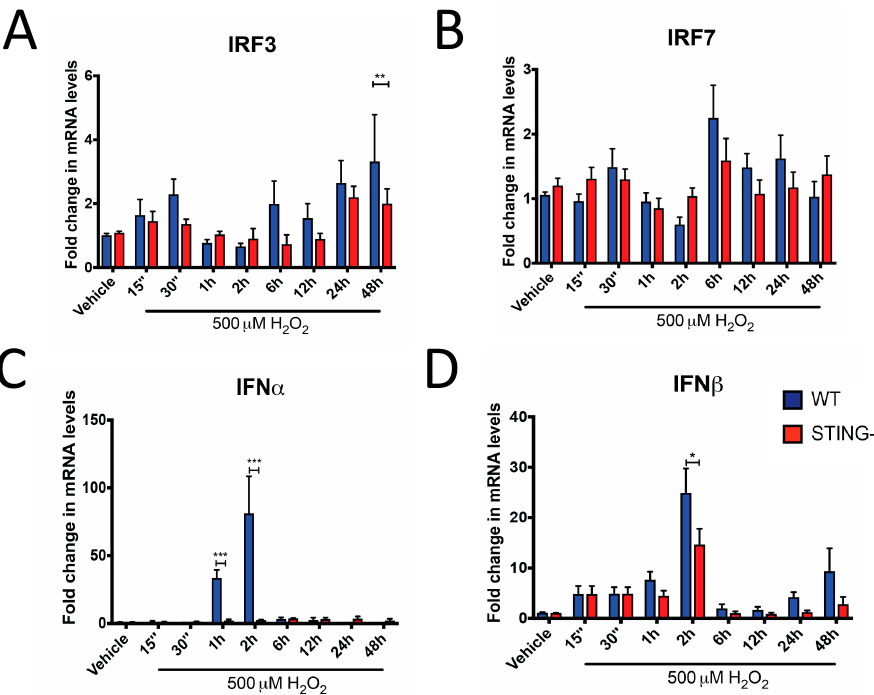
Figure 3. Type-I interferon (IFN) signaling is upregulated by H 2 O 2 in a STING-dependent manner. WT and STING − / − cells were treated with 500 µ M H 2 O 2 for the indicated time points before qPCR analysis was performed to determine ( A ) IRF3, ( B ) IRF7, ( C ) IFN α and ( D ) IFN β mRNA levels ( n = 4). Data represent mean ± SEM, * p < 0.05, ** p < 0.001, *** p < 0.0001.